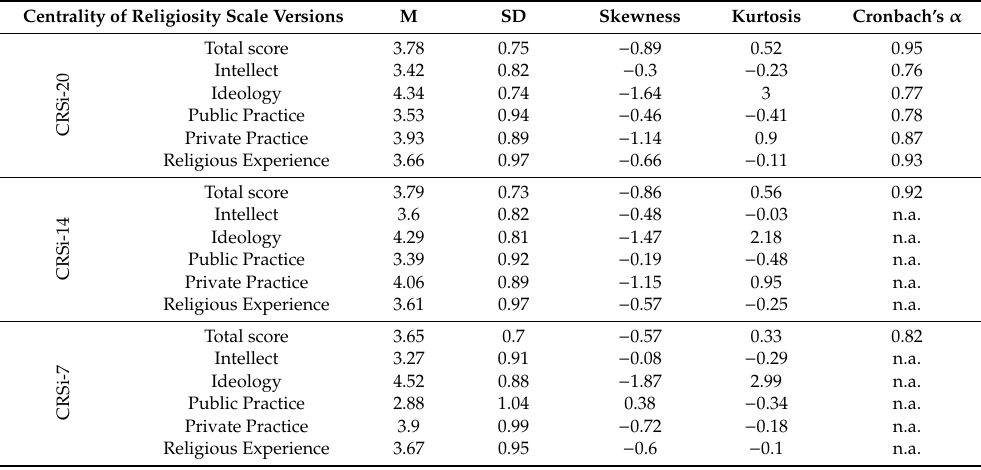
Table 2. Descriptive Statistics of the interreligious CRS.